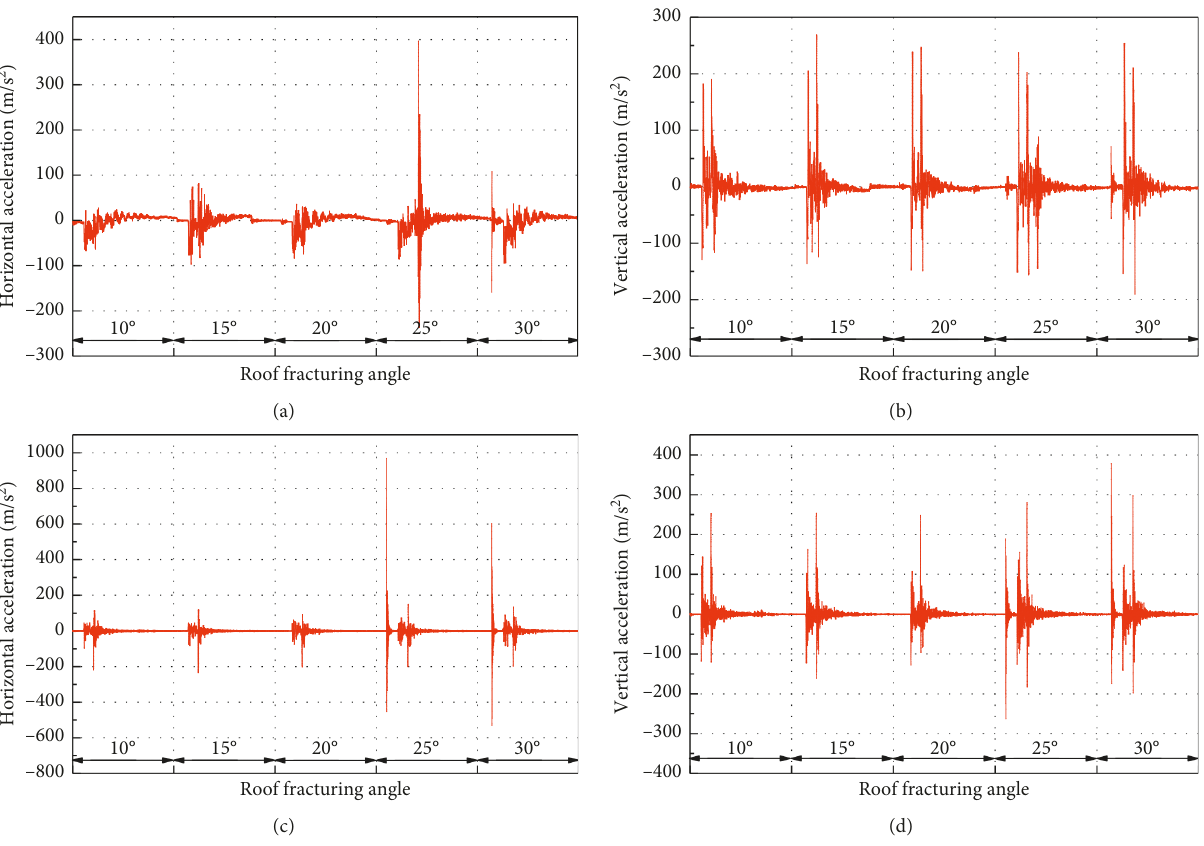
Figure 13: Dynamic responses of the entry with different roof fracturing angles: (a) horizontal acceleration of the gangue rib; (b) vertical acceleration of the gangue rib; (c) horizontal acceleration of the coal rib; (d) vertical acceleration of the coal